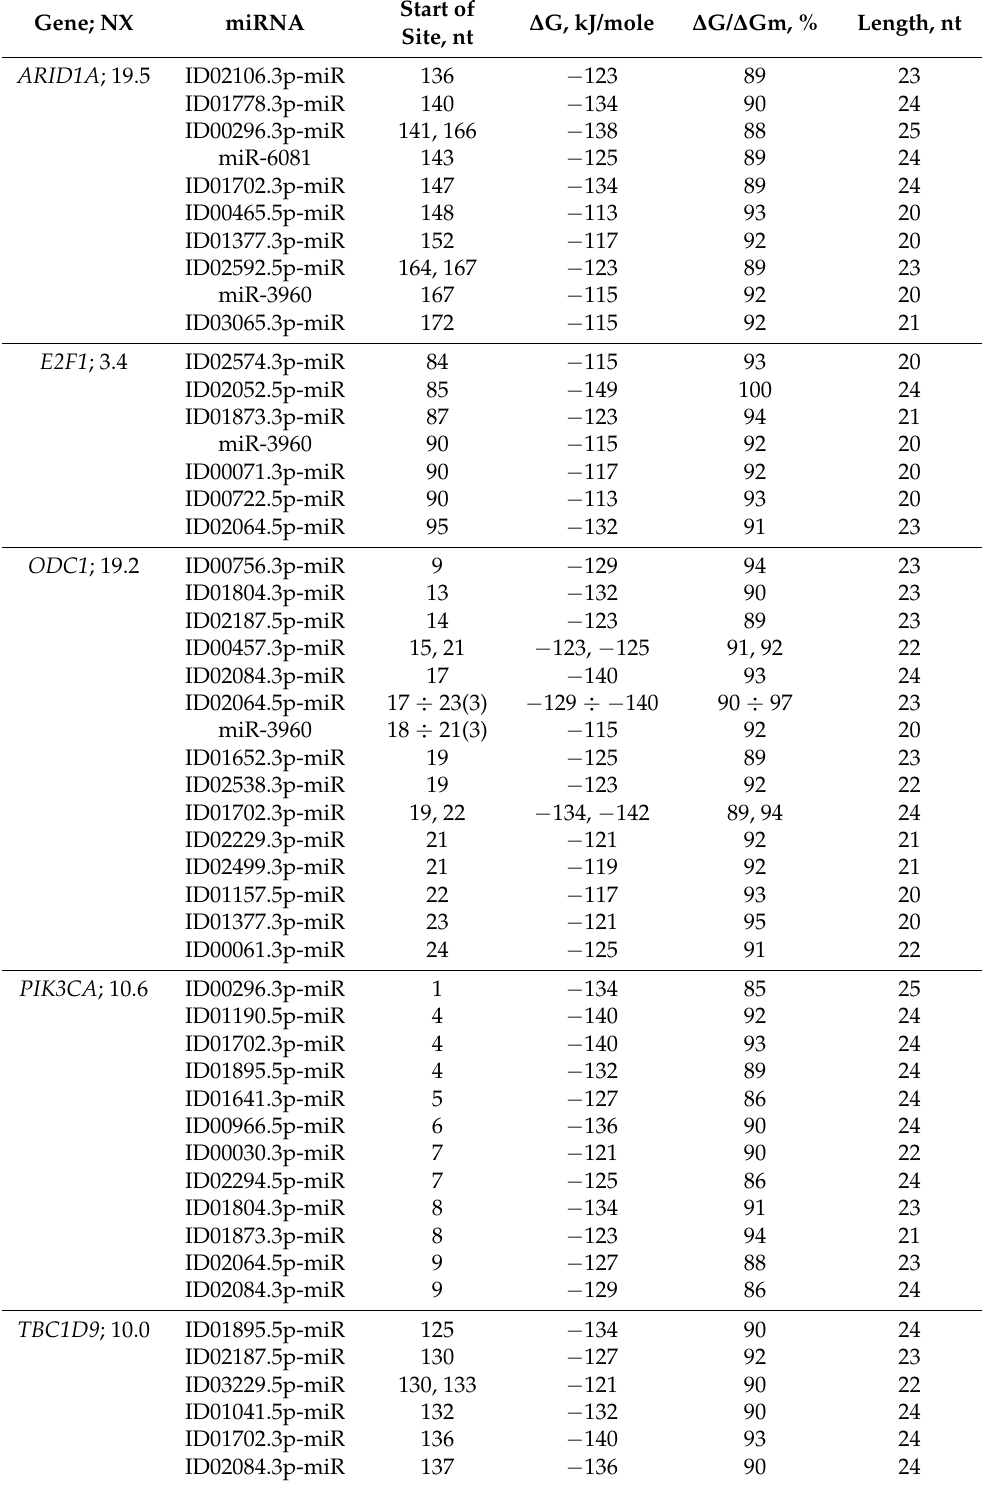
Table 1. The characteristics of the miRNA interactions with 5 (cid:48) UTR mRNAs of gastric cancer candi- date